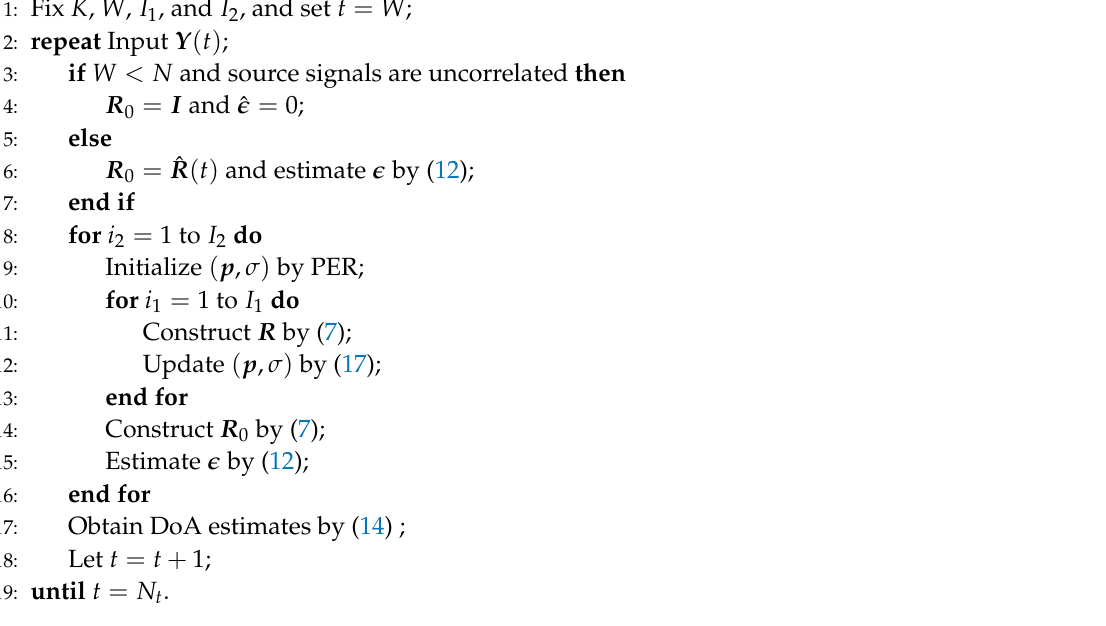
Algorithm 1 A Sequential Implementation of C-SPICE